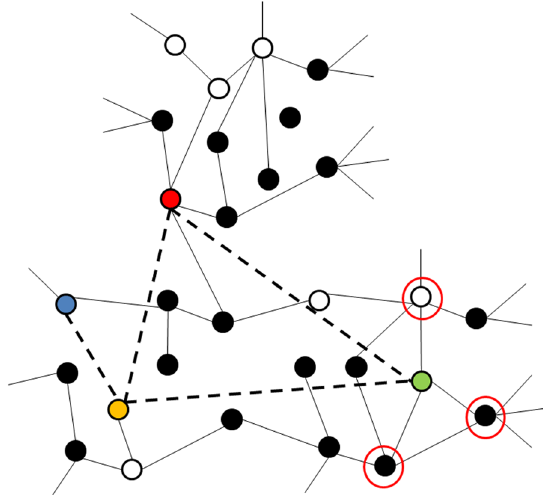
Fig. 2 A schematic diagram showing the behavior of a social-type actor. The resource patch network is represented by the black nodes and solid black lines. Filled black circles are patches with resources and open circles are empty patches. Red, yellow, blue and green nodes are individual actors and the dashed lines represent their social ties. Here, the red actor is allowed to use his social ties for collecting resources, and by chance he uses the tie connected to the green actor. The red actor then randomly picks a patch near the green actor (one of the nodes circled in red) and takes away a resource if it exists. Note that an actor immediately takes away a resource once he occupies a patch; therefore in the fi gure, the patches occupied by red, yellow, blue, and green actors have no resources